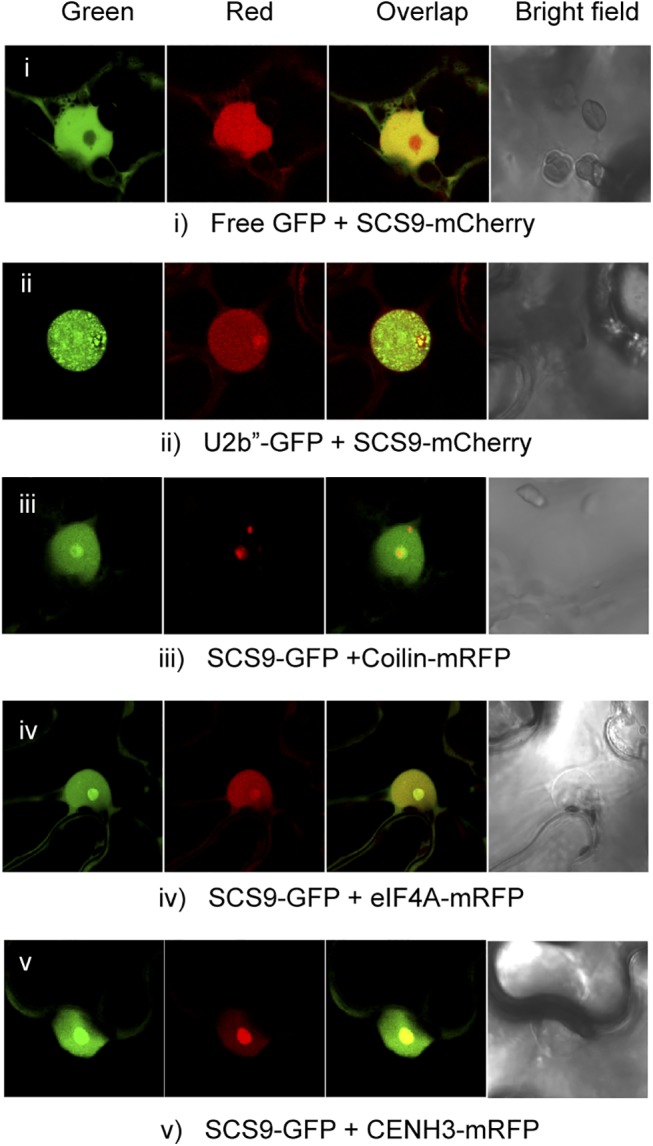
SCS9 nuclear localization.Co-localization patterns of SCS9, fused to either GFP or mCherry, with free GFP (panel i) and several different nuclear tagged proteins, including U2b” (panel ii), Coilin (panel iii), eIF4A (panel iv), and CENH3 (panel v) in epidermal cells from N. benthamiana transfected with each respective pair of constructs; evaluated by confocal microscopy.